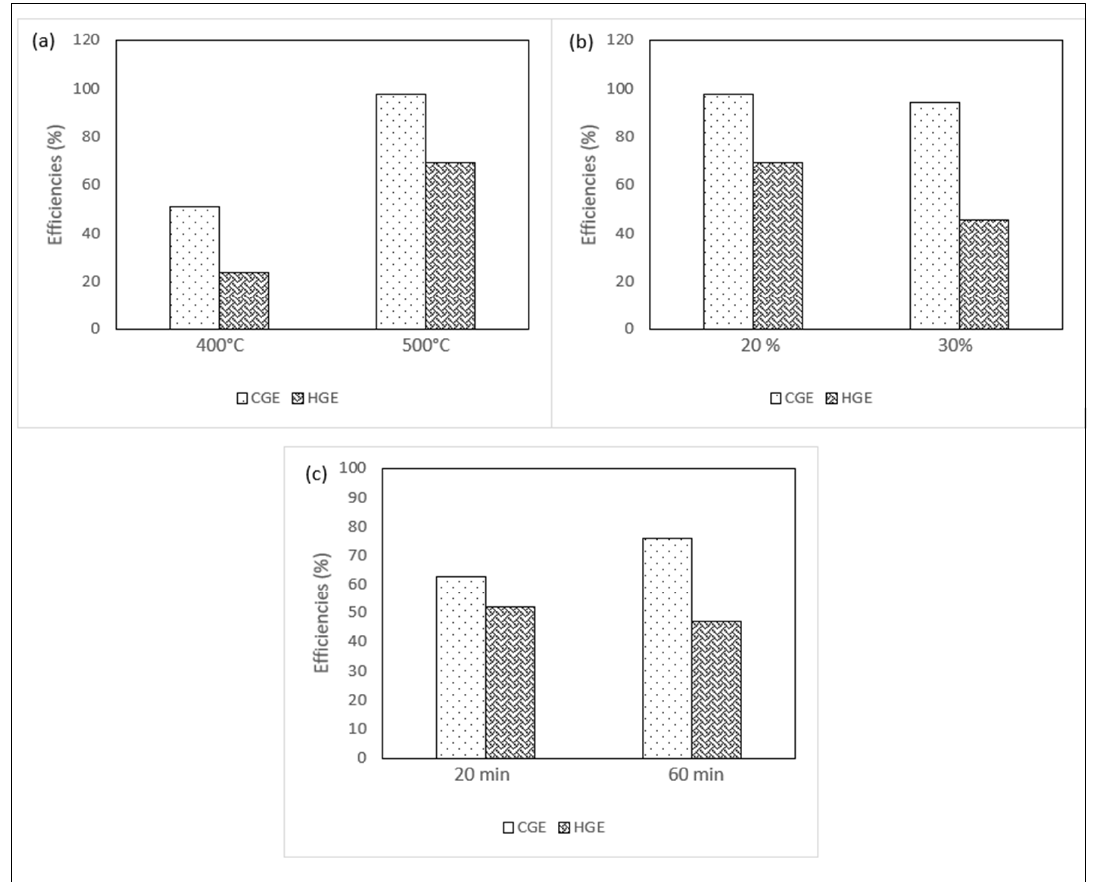
Figure 13. E ff ect of temperature ( a ), biomass loading ( b ) and time ( c ) on gasi fi cation e ffi ciencies: Figure 13. Effect of temperature ( a ), biomass loading ( b ) and time ( c ) on gasification efficiencies: CGE CGE and HGE. and